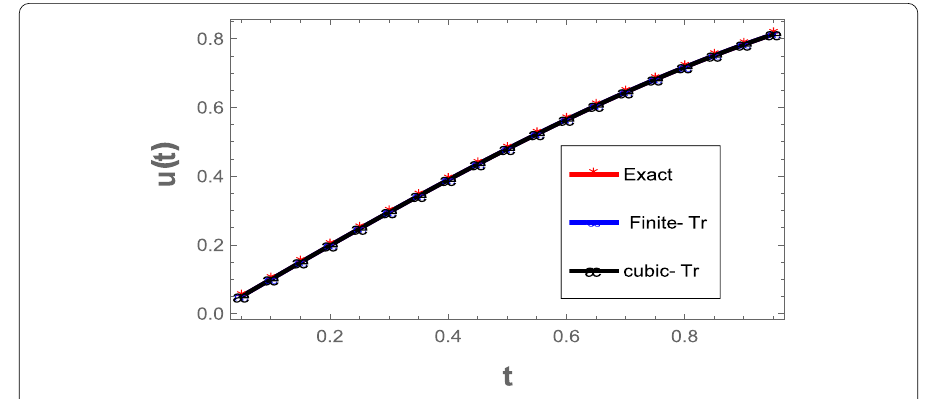
Figure 1 Comparison between the numerical and exact solutions of Test problem 1